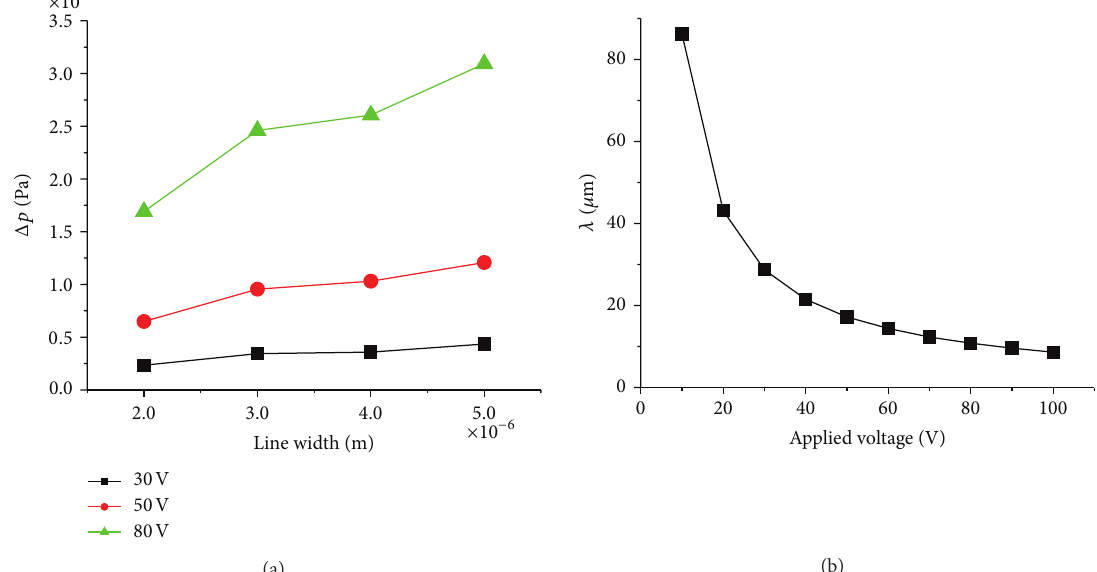
Figure 4: (a) Δ𝑝 with different applied voltage, (b) 𝜆 the period of the separated structures with different applied